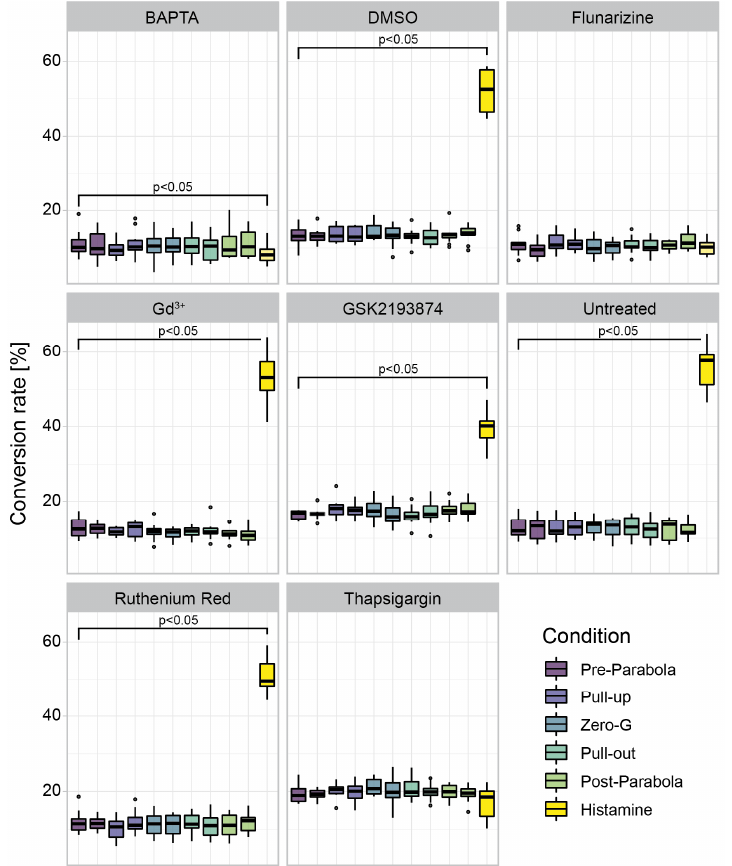
Figure 6. Conversion rates of cells transfected with CaMPARI2 ‐ F391W and subjected to a parabolic flight. Eight 96 ‐ well plates were used for each of the three parabolic flights. Each plate was treated with one of the displayed drugs 5 h before photoconversion. The cells were illuminated over four parabolas (0, 10, 20, and 30). A conversion rate was calculated for each flight phase and the histamine post ‐ flight control ( n = 12, 3 flights, 4 parabolas) using the IncuCyte 2021A mask described in 2.10. Brackets indicate significant differences compared to the Pre ‐ Parabola phase ( p < 0.05 using ANOVA and Tukey posthoc tests).